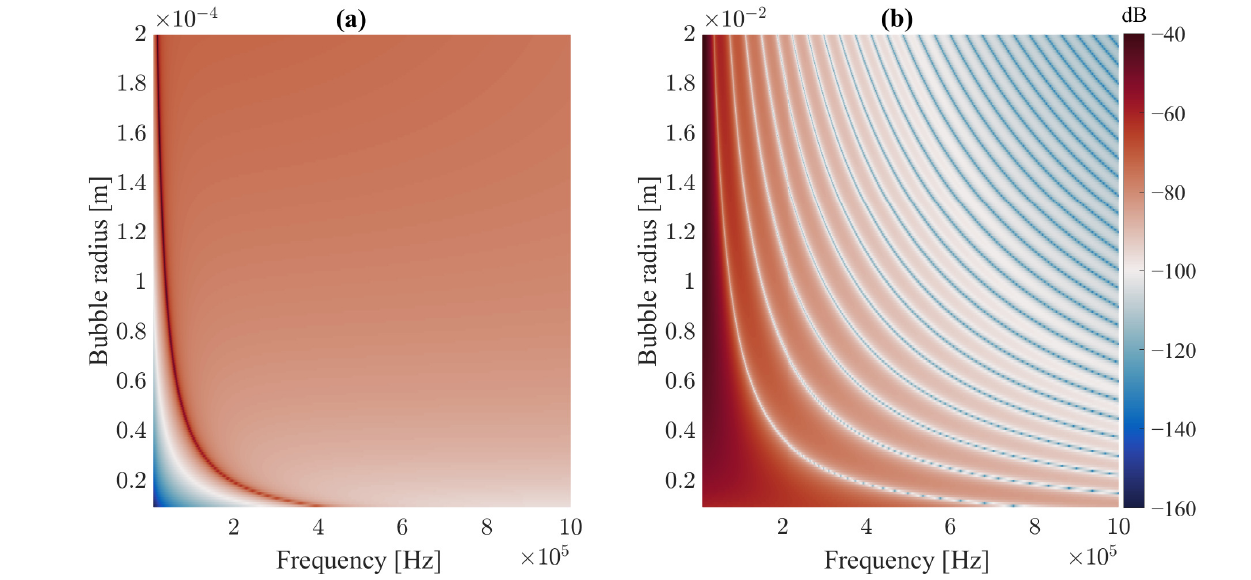
Figure 2. Target strength of a single gas bubble with a different radius at the acoustic frequency ranging from 10 kHz to 1 MHz: ( a ) radius of 0.01–0.2 mm and ( b ) 1–20